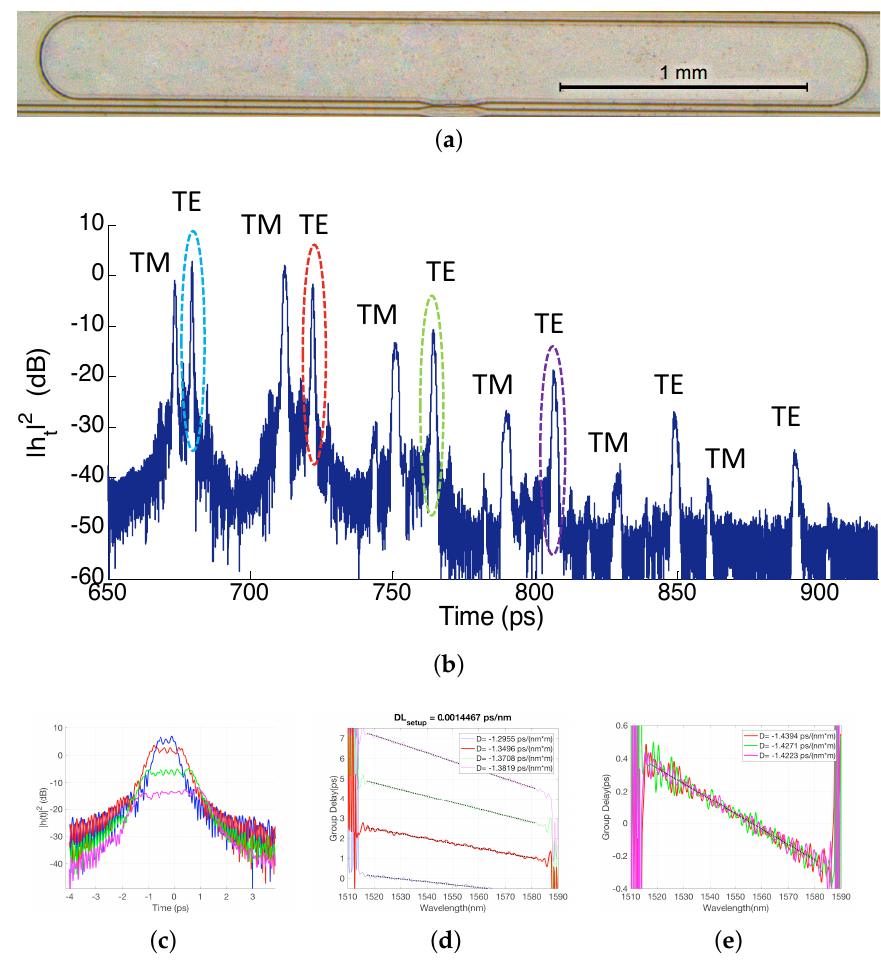
Figure 6. ( a ) Ring resonator test structure devised for the characterization of the group velocity dispersion and birefringence, ( b ) Optical Frequency Domain Reflectometry (OFDR) trace from the ring resonator, with TE and TM pulses labeled, ( c ) TE pulses sliced and collated, exhibiting broadening due to group velocity dispersion (GVD), and ( d , e ) their corresponding group